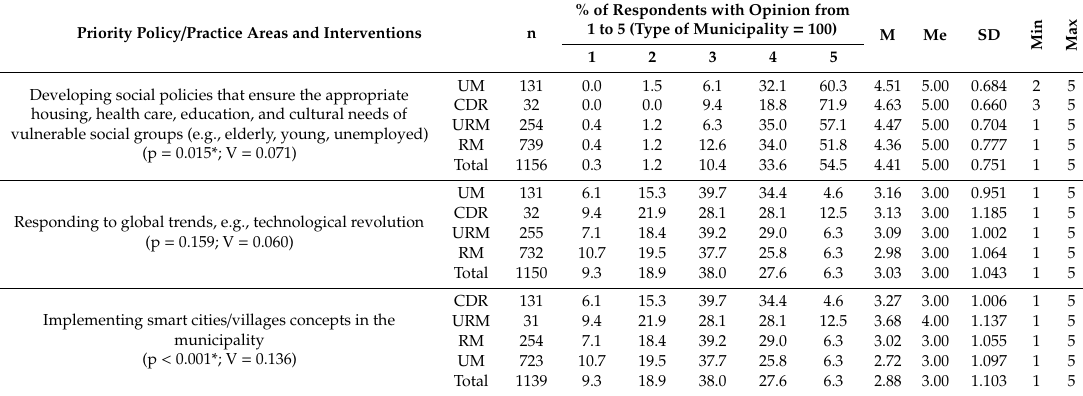
Table 4. Perceptions about individual priority policy / practice areas and interventions by type of